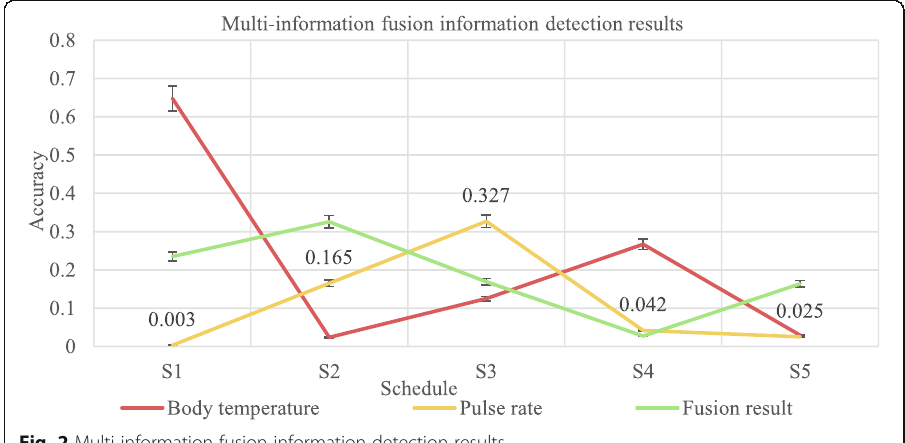
Fig. 2 Multi-information fusion information detection results